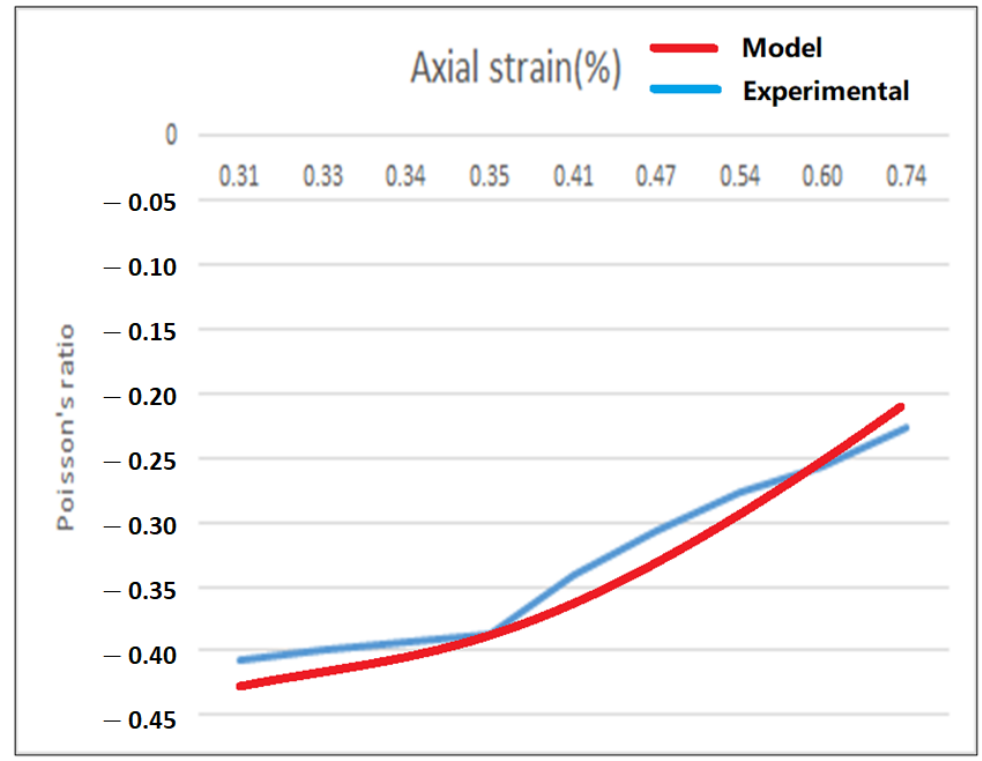
Figure 14. Computational model results vs. experimental results.